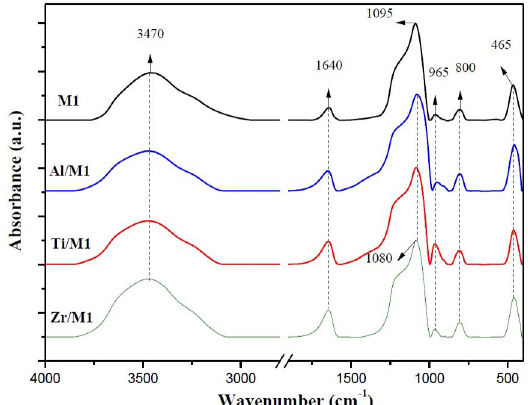
Figure 3. FTIR spectra for pure M1 calcined materials and incorporated with